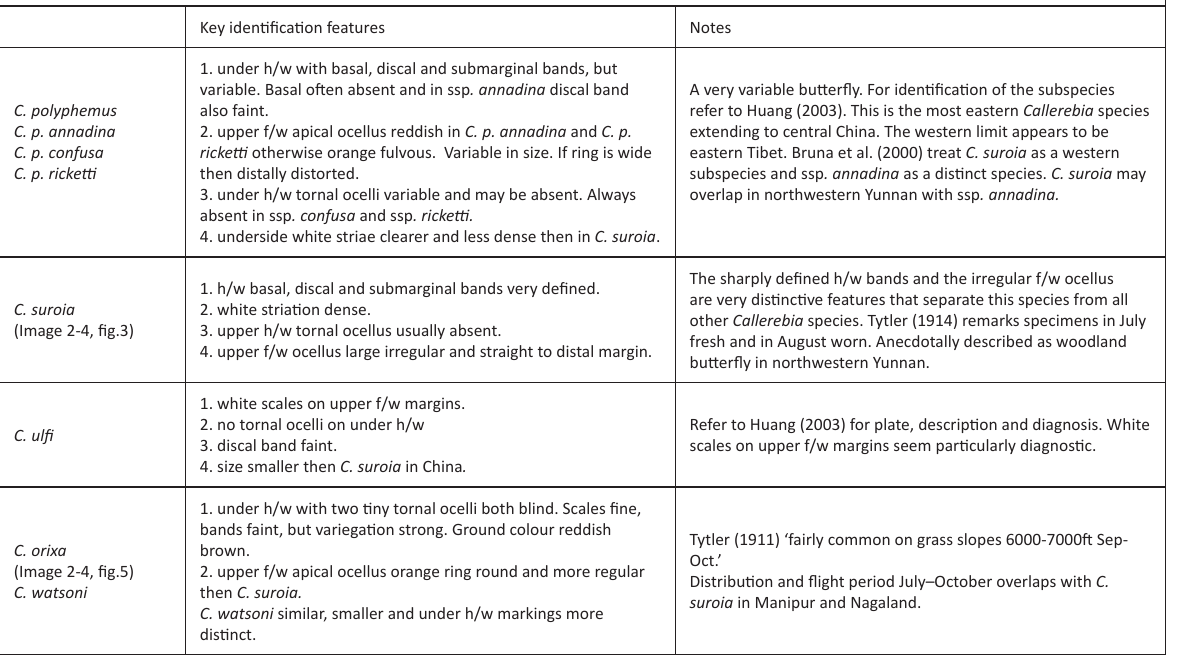
Table 1. Comparison of Callerebia dibangensis sp. nov and C. scanda opima Callerebia dibangensis sp. nov., male (Images 2–4, fig. 1) f/w length (mm) 34 29 f/w costa, apex and termen rounded producing a very broad Less rounded. Termen more inwardly facing. Wing less broad. Ratio wing shape and round wing. Ratio of height to width approx.0.76. of height to width approx.0.67. Upperside Dark chocolate brown. Blackish. Usually paler. Paler on termen margin between v1 to v7. Pale Paler on whole termen margin and apical region. Lacks the triangular region around apical ocellus from costa tapering f/w ground colour alternating contrasting area distal to apical ocellus that is posteriorly. Obscure dark submarginal band formed from these typical in opima. Obscure dark submarginal band. contrasting regions. Very prominent and large. Ring orange and wide (2.4mm) and colour pretty constant around whole ring. Ratio to inner black f/w apical ocellus ocellus approximately 0.42. to inner black ocellus approximately 0.24. Shape more oval, Shape more round then oval. posteriorly more produced. h/w tornal ocelli h/w termen cilia A mixture of dark brown and white appears indistinct. White and brown tipped appears fairly prominently as a white line. Underside Lighter brown with more reddish and complex tones in f/w ground colour Dark chocolate brown. especially around apical ocellus. h/w white striae Less dense forming drifts like patterns emphasised by dark Dense and more irregular. Less contrast between white striae. (Image 4, figs. 1–2) brown scales. Violet tones to white striae. More yellow tones to white striae. apical ring Outer reddish-red ring much narrower then orange ring. Outer reddish-ring wider than inner fulvous-yellow ring. h/w ocelli 2 and 1c white post-discal Appear to be absent, but possibly present extremely minutely Usually present if only minutely, but can be absent. ocelli h/w in space 6.